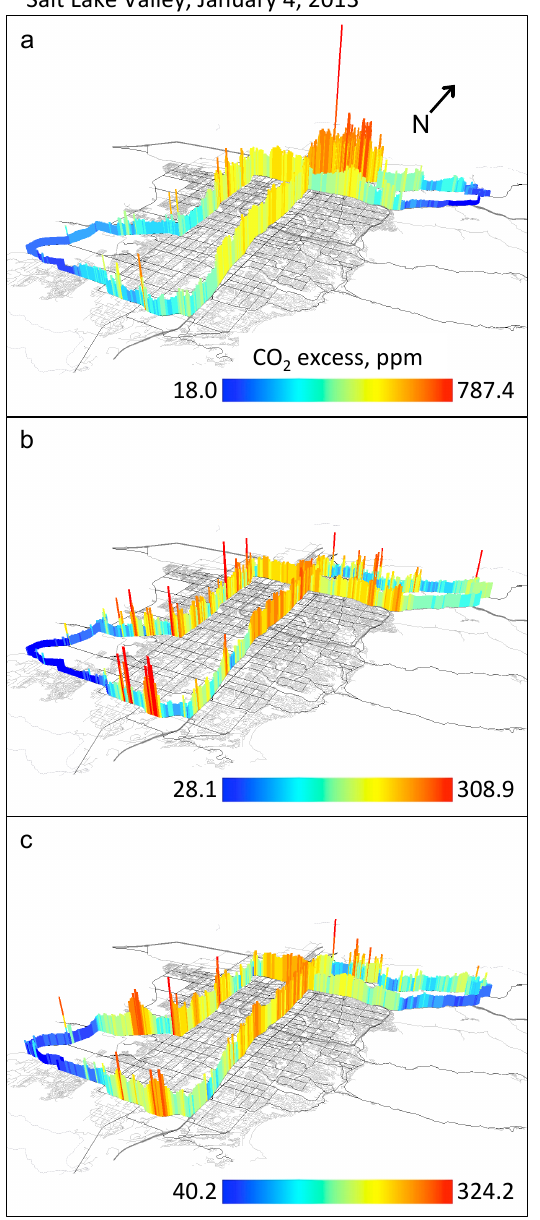
Figure 5. The CO 2 mole fraction across Salt Lake Valley, Utah, USA. Morning, afternoon, and nighttime periods are shown in pan- els a, b, and c, respectively. Values shown represent mole fraction above background mole fraction obtained from Wendover, Utah. The underlying black and white grid shows roads, and the color bar shows the range of values observed.